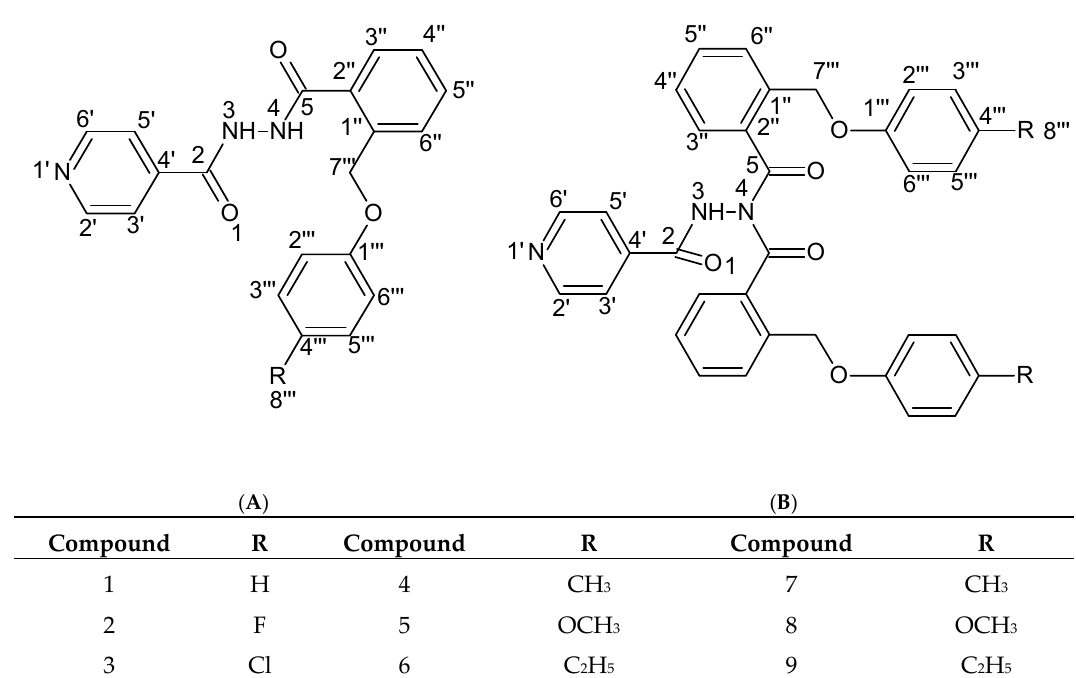
Figure 8. General formula of newly synthesized N,N ′ -diacylhydrazines (compounds 1 – 6 ) ( A ) and N,N,N ′ -triacylhydrazines (compounds 7 – 9 ) ( B ).